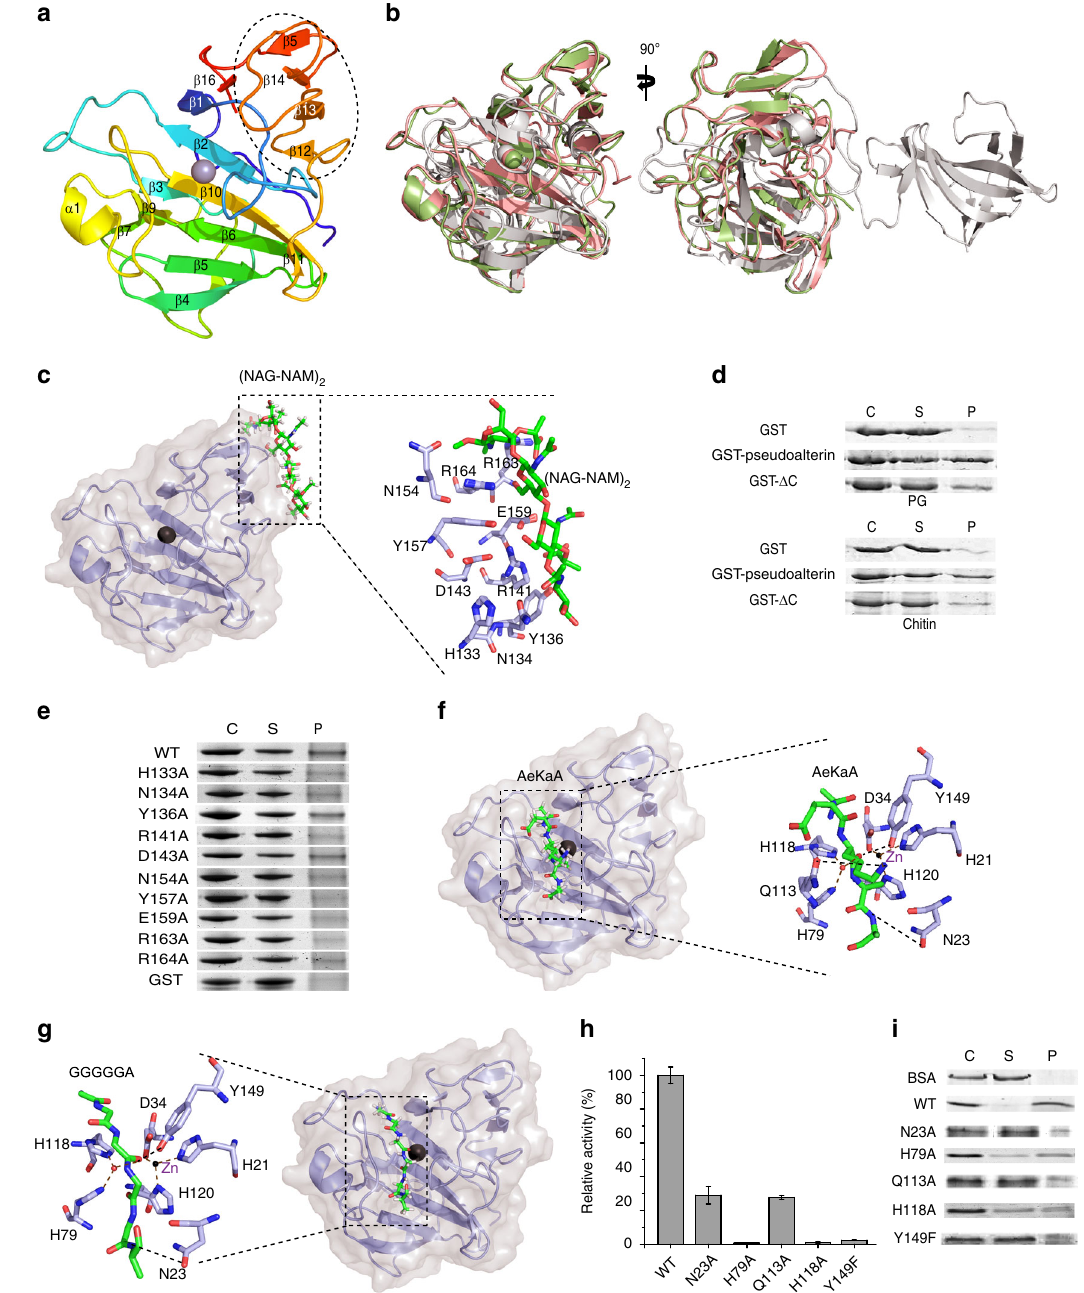
Fig. 6 Structural basis of PG binding and degradation by pseudoalterin. a The overall structure of pseudoalterin. The C-terminal domain is marked in a black dotted box. b Structural superposition of pseudoalterin with LasA and lysostaphin. On the left is the front view and on the right is the side view. Pseudoalterin structure is colored in green, LasA in pink and lysostaphin in gray. c Model of the pseudoalterin:(NAG – NAM) 2 binary complex constructed by MSD. The interface of pseudoalterin with (NAG – NAM) 2 in the black dotted box is ampli fi ed. e SDS-PAGE analysis of the binding ability of GST- pseudoalterin and its site-directed mutants to PG. d SDS-PAGE analysis of the binding ability of GST-pseudoalterin and its C-terminal domain-deleted mutant ( Δ C, N134-R173) to PG and chitin. f Model of the pseudoalterin:AeKaA binary complex constructed by MSD. The interface of pseudoalterin with AeKaA in the black dotted box is ampli fi ed. g Model of the pseudoalterin:GGGGGA binary complex constructed by MSD. The interface of pseudoalterin with GGGGGA in the black dotted box is ampli fi ed. h Activities of pseudoalterin and its mutants to PG. Values are normalized against the activity of WT pseudoalterin. Data are from triplicate experiments (mean ± SD). i SDS-PAGE analysis of the PG-binding ability of pseudoalterin and its mutants. In d , e and i , the experiments were performed with a fi xed amount of protein (0.1 mg ml − 1 in d and e , 0.05 mg ml − 1 in i ) and substrates (2.0 mg). “ C ” represents the total amount of protein. “ S ” and “ P ” refer to the amount of protein present in the supernatant and the pellet after centrifugation, respectively. Each graph is a representative of at least three repeats. Source data are provided as a Source Data fi